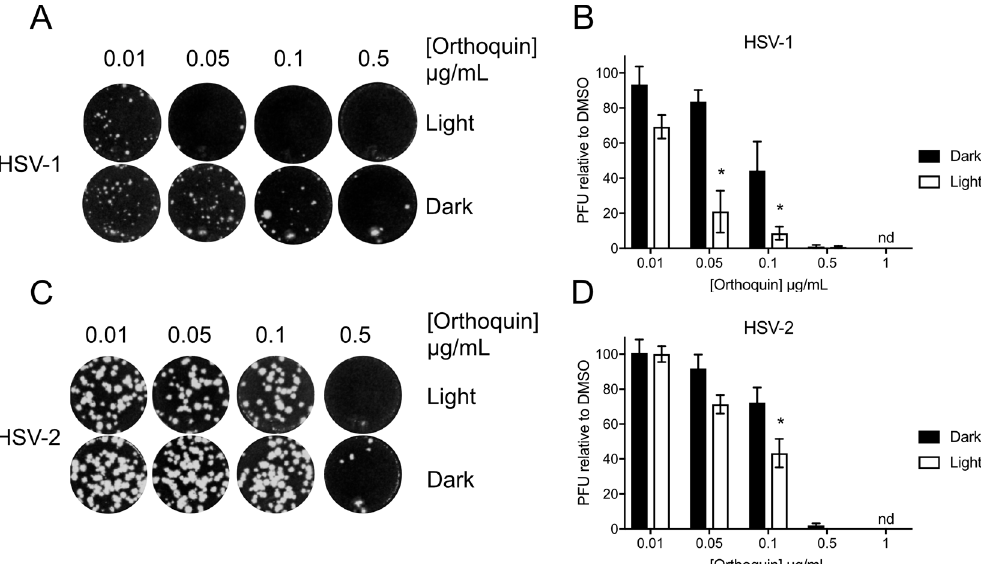
Figure 4. Light-dependent reduction of HSV-1 and HSV-2 plaque formation with Orthoquin treatment. HSV-1 and HSV-2 inocula were mixed with Orthoquin at concentrations ranging from 0.01 to 1 µ g/mL and exposed to a 65 W LED light in clear (light) or black (dark) tubes for 10 min (HSV-1) or 5 min (HSV-2). Treated inocula were used to infect HeLa cell monolayers, as described in the methods. ( A ) Representative image of HSV-1 plaque assay, quantified in ( B ). ( C ) Representative HSV-2 plaque assay, quantified in ( D ). Values in ( B , D ) are normalized to the number of PFUs detected in DMSO, light- or dark-treated wells. n = 3 ± SEM from three independent biological replicates. * = p < 0.05 by two-way ANOVA. nd = none detected.